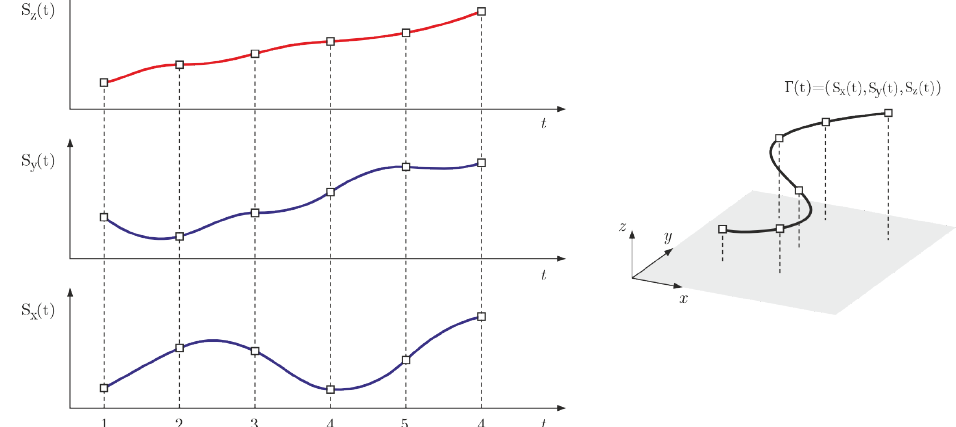
Figure 5. Example of interpolation functions for a solution with five nodes, whose coordinates are represented using squares. Note that S x ( t ) and S y ( t ) (in blue) are natural splines, while S z ( t ) (in red) is a monotone Hermite